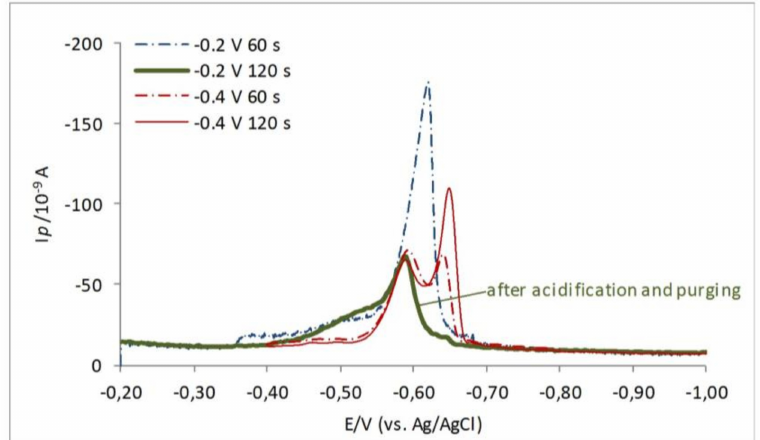
Figure 3. CSSWV curves of the solution containing 65.0 nM 3-MPA and 32.5 nM Na 2 S, recorded at the di ff erent deposition potentials with di ff erent accumulation times, as illustrated. Green solid (bold) line is recorded after purging the mixture solution with N 2 when all added sulfide was stripped out. Experimental conditions: E d = − 0.2 and − 0.4 V, t a = 60 and 120 s, A = 25 mV, f = 80